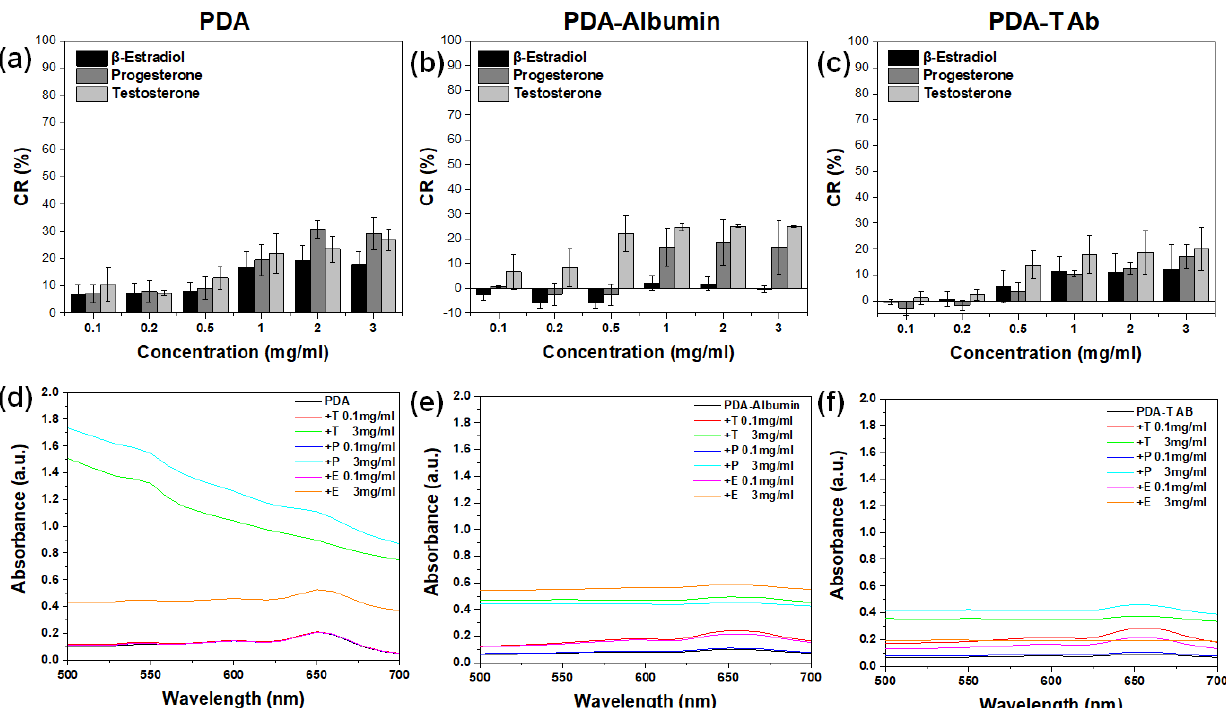
Figure 4. CR of ( a ) PDA, ( b ) PDA-Albumin and ( c ) PDA-T Ab after incubating with sex steroid hormones ( β -estradiol, progesterone and T). UV-Vis absorption spectra of ( d ) PDA, ( e ) PDA-Albumin and ( f ) PDA-T Ab when incubating with sex steroid hormones at low (0.1 mg/mL) and high (3 mg/mL) concentrations.